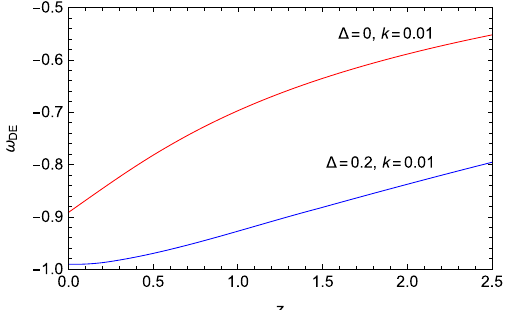
Fig. 8 Evolution of DE EoS parameter, as a function of redshift z , for C = 3 , in unit of M 2 p = 1. The lines corresponds: red: Δ = 0 and k = 0 . 01 ; blue: Δ = 0 . 2 and k = 0 .